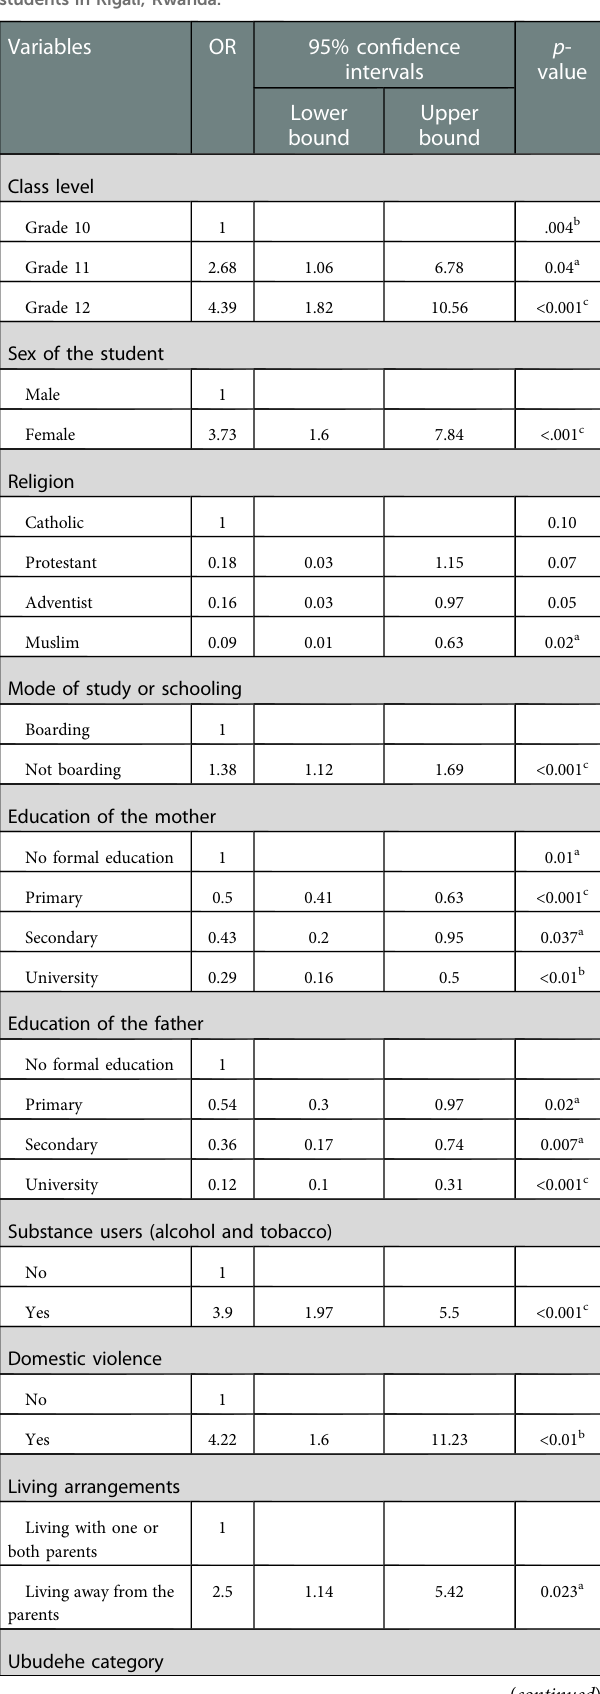
TABLE 3 Factors associated with RSB among sexually active school students in Kigali,